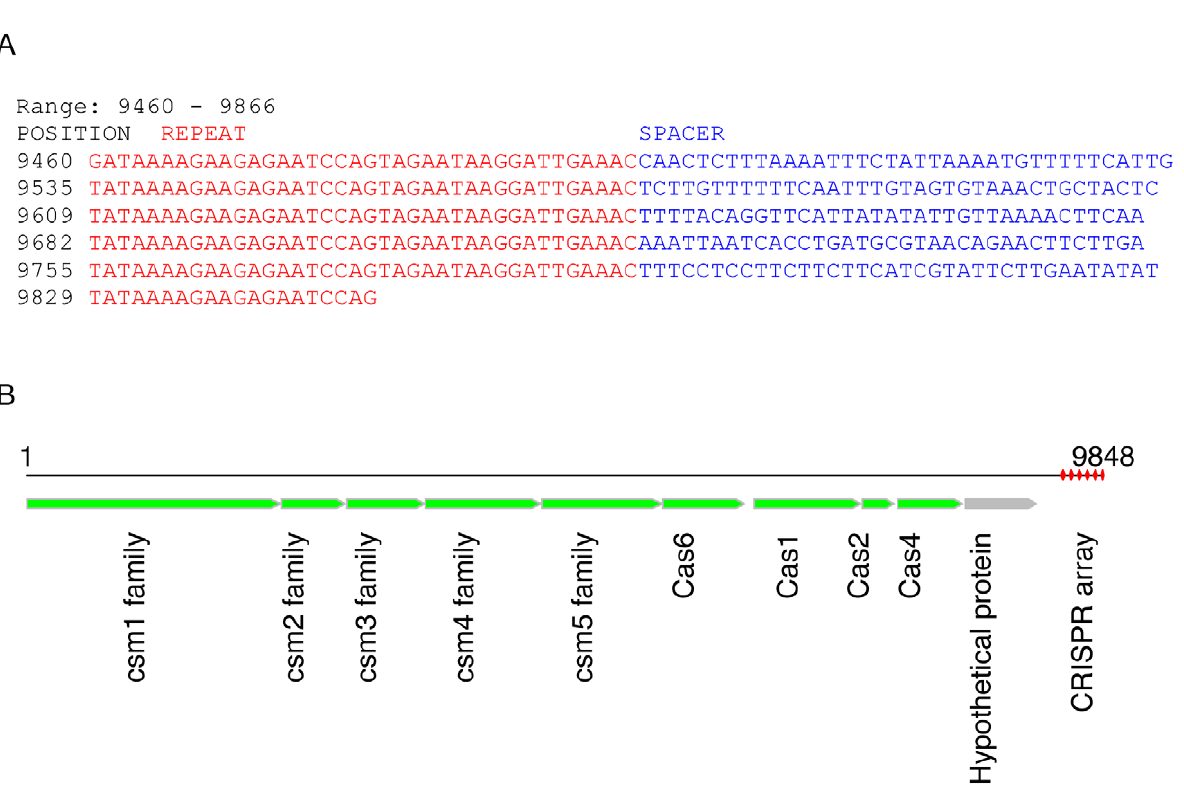
Figure 2. A potentially novel CRISPR array identified in a contig (9848 bases) from sample SRS012279. (A) This CRISPR array has 6 copies of the repeat (repeat sequences shown in red font and spacer shown in blue). (B) shows our annotation of this contig, in which the CRISPR array is highlighted in red. We first predicted ORFs in this contig using FragGeneScan [31], and then blasted predicted proteins against the nr protein database to retrieve annotations; for example, the predicted Cas1 is similar to the Cas1 protein identified in Leptotrichia buccalis C-1013-b (accession ID: YP_003163976), with 60% sequence identify and 80% sequence similarity.